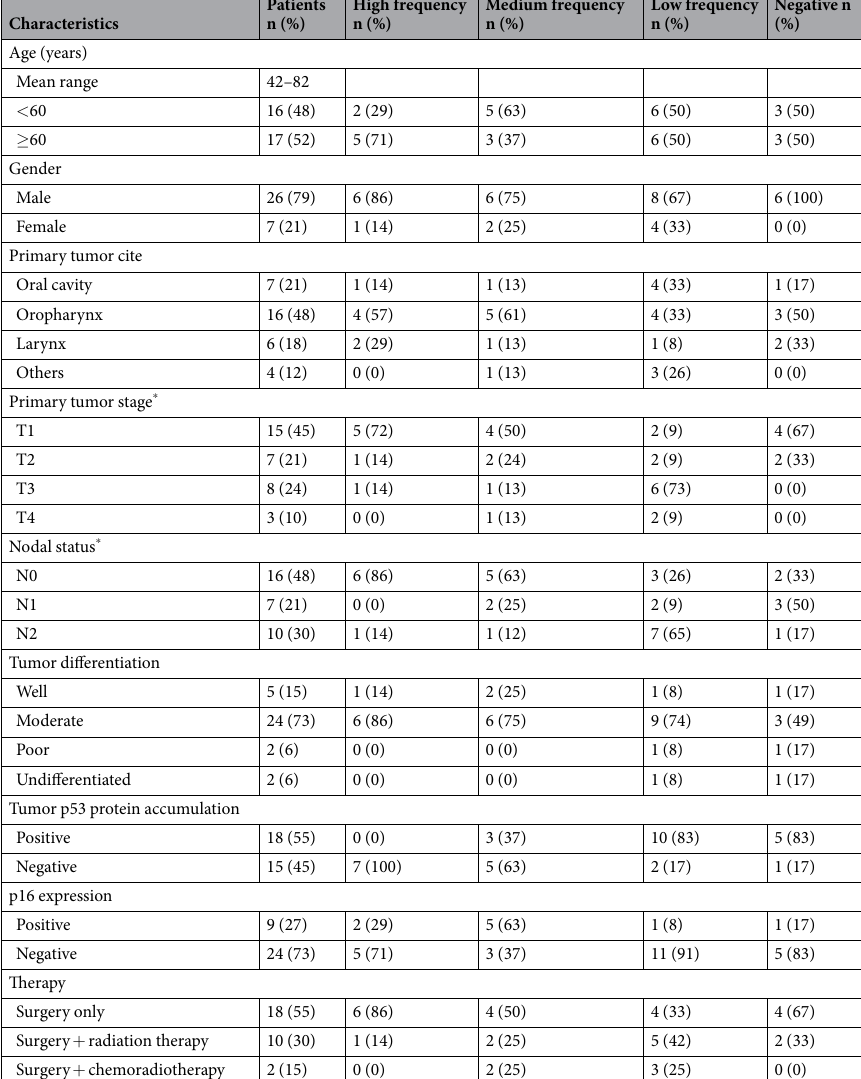
Table 1. Clinicopathologic characteristics and frequency of circulating wt p53-specific tet 264–272 + CD8 + T cells in 33 patients with HNSCC who donated PBMC for this study. * TNM classification of malignant tumors according UICC 7th